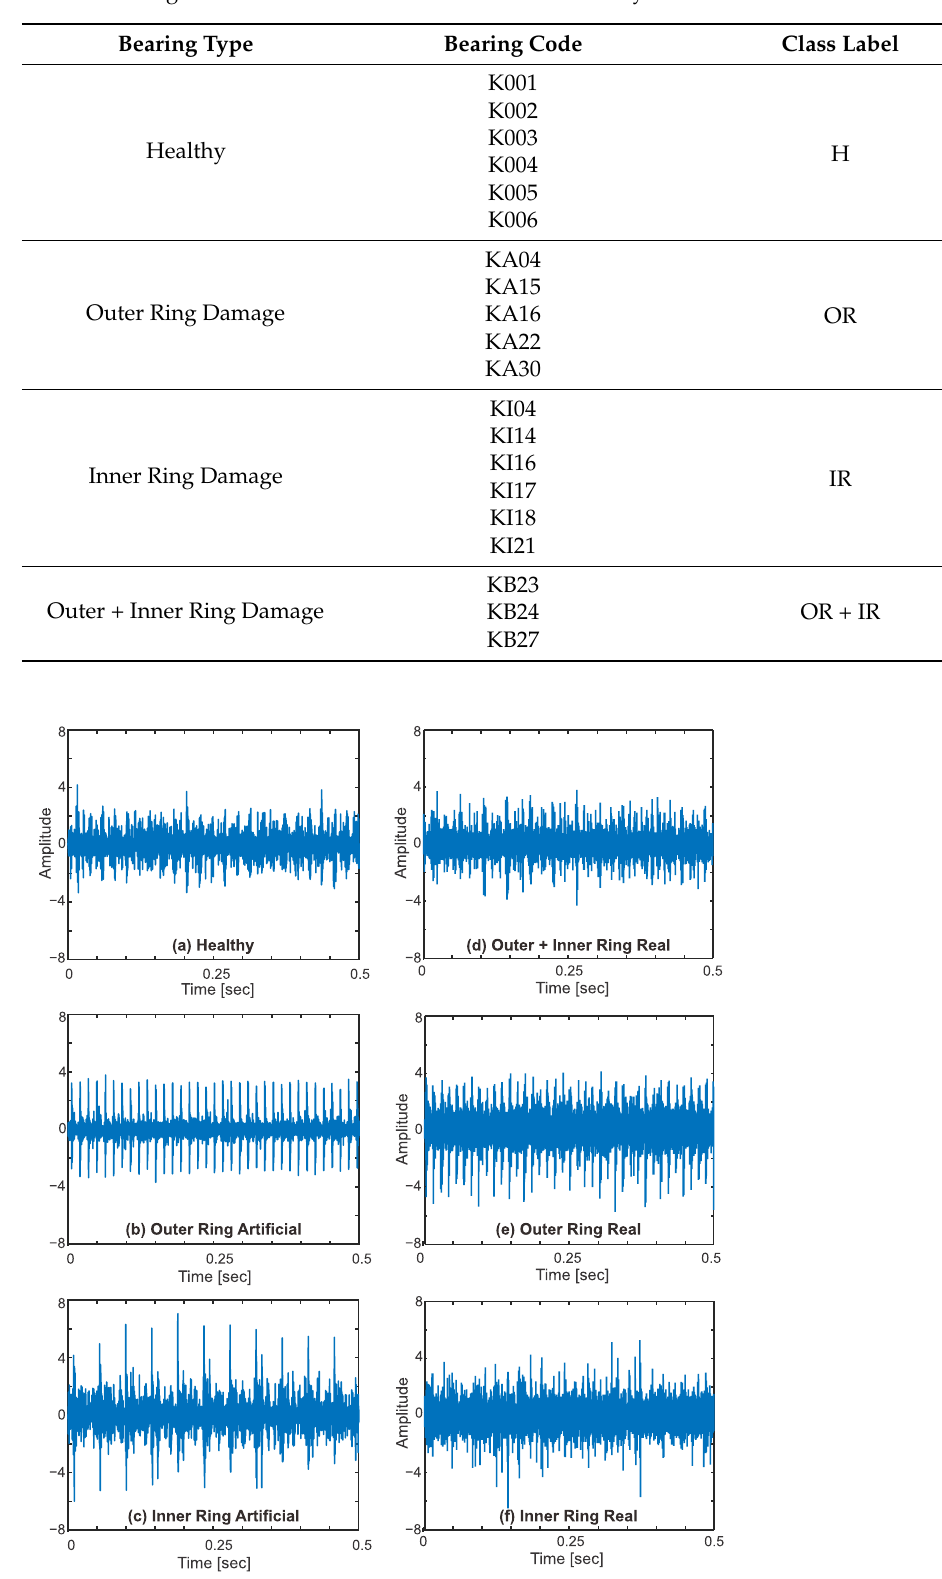
Table 3. Arrangement of the PU dataset with faults inflicted by accelerated lifetime tests.